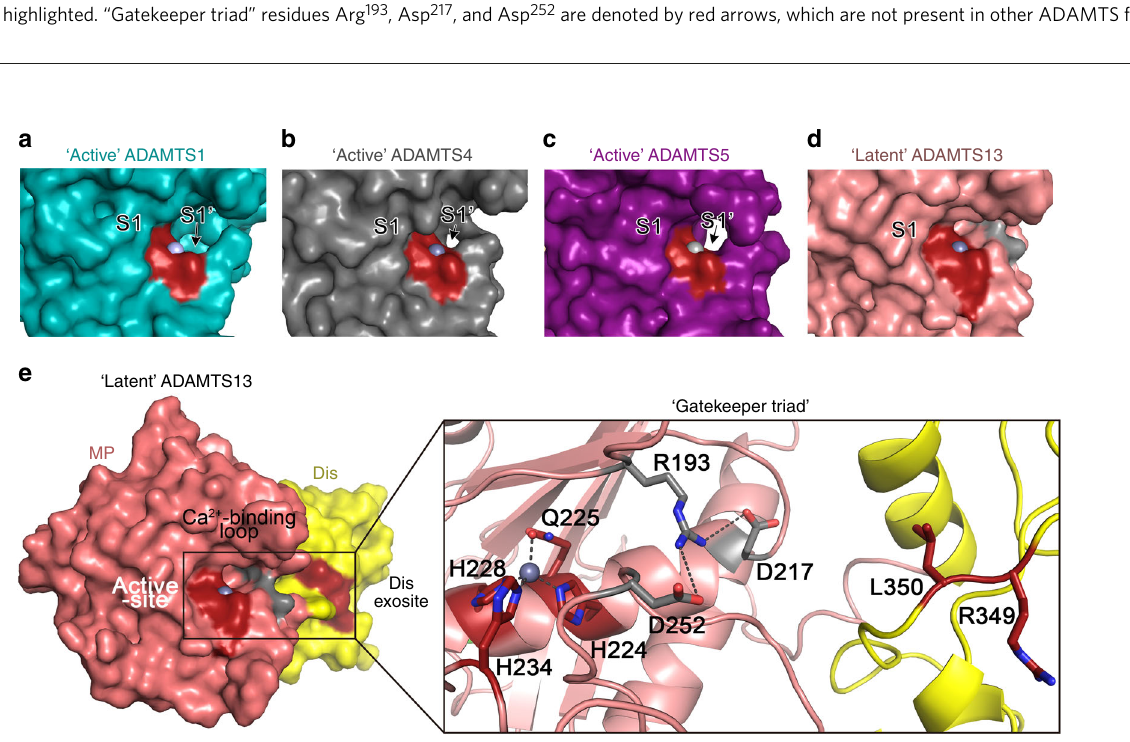
Fig. 7 Structure and sequence comparison of ADAMTS13 metalloprotease (MP) domain. a Crystal structure of the ADAMTS13 MP domain with the topology β 1- α 1- α 2- β 2- α 3- β 3- β 4- β 5- α 4- α 5. Loop 180 – 193, loop 231 – 263, the active-site, and the metal-binding sites are indicated. Two N-linked glycans are shown in purple. Surface residues Leu 147 , Leu 151 , Leu 185 , Val 192 , and Val 195 (light green) form a hydrophobic patch above the active-site that likely contributes to the S1 pocket. Asp 187 and Glu 233 (dark teal) are negatively-charged residues that are unique to ADAMTS13. To the right of the active-site, Arg 193 , Asp 217 , Asp 252 and Ala 254 (blue) form ionic interactions with each other that bridge loops 180 – 193 and 231 – 263. b Four metal ions are bound by the MP domain: the Zn 2 + ion (gray sphere) is coordinated by His 224 , His 228 , and His 234 . Three Ca 2 + ions are bound (green spheres); a single Ca 2 + ion (Ca1) bound by loop 180 – 193 is coordinated by Asp 182 , Glu 212 and the carbonyl backbone of Leu 183 , Arg 190 , and Val 192 . Two Ca 2 + ions (Ca2 and Ca3) are bound in a double Ca 2 + -binding site on the rear side of the MP domain. c Superimposition of human ADAMTS13 MP domain (salmon) with the structures of human ADAMTS1 (light blue, 1.19 Å root-mean-square deviation (RMSD), 971 C α atoms, PDB 3Q2G [https://doi.org/10.2210/pdb3Q2G/pdb]), ADAMTS4 (gray, 1.10 Å RMSD, 923 C α atoms, PDB 4WK7 [https://doi.org/10.2210/pdb4WK7/pdb]), and ADAMTS5 (purple, 1.10 Å RMSD, 832 C α atoms, PDB 3LJT [https://doi.org/10.2210/pdb3LJT/pdb]). Regions enclosed with black boxes are enlarged in the right panel. Top panels show the Ca 2 + - ADAMTS5. Bottom panels highlight differences in the loop 231 – 263. In ADAMTS1, 4 and 5 in there is an α -helix in this loop, whereas in ADAMTS13 this α - helix is not formed and is presented as the α -helix-less loop. d Sequence alignment of ADAMTS13 MP domain residues 171 – 263 with other ADAMTS family members. Identical residues are colored white on a red background and similar residues are red on white background. The Ca 2 + -binding loop (loop